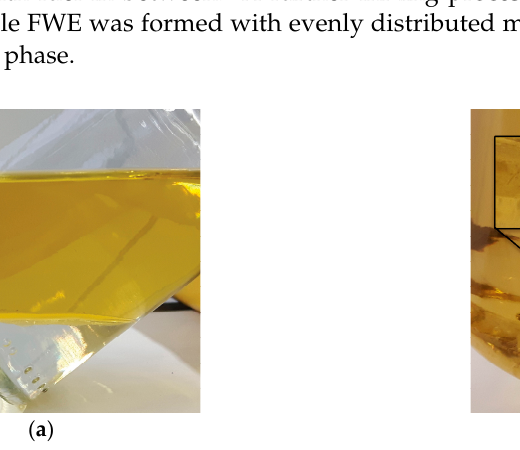
Figure 3. Water in fuel: ( a ) without surfactant; ( b ) with surfactant (from research conducted by the authors).